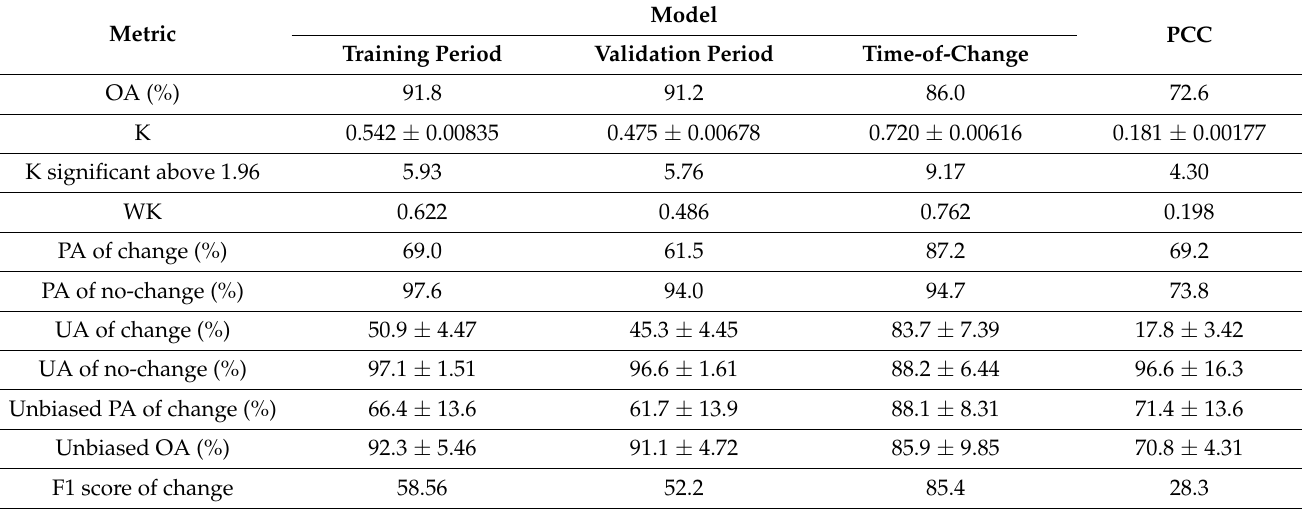
Table 4. Accuracy measures and associated confidence intervals. The model shows three sets of statistics corresponding to three sets of analysis and three sets of accuracy assessment data (Sets A, B, and E). The training period are the values from the selected 0.93 threshold iteration. The validation model is directly comparable to the PCC as both use the same sample set (Set B). Time-of-change analysis was performed over the oversampled area of Haydon Wick for the increased time period of 2002–2015. Kappa values are presented with estimations of large sample variance using Delta method [46]. Note that for UA, OA, K, and F1 score, partial-change is counted as no-change . For WK, partial-change is in half agreement with change , and full agreement with no-change